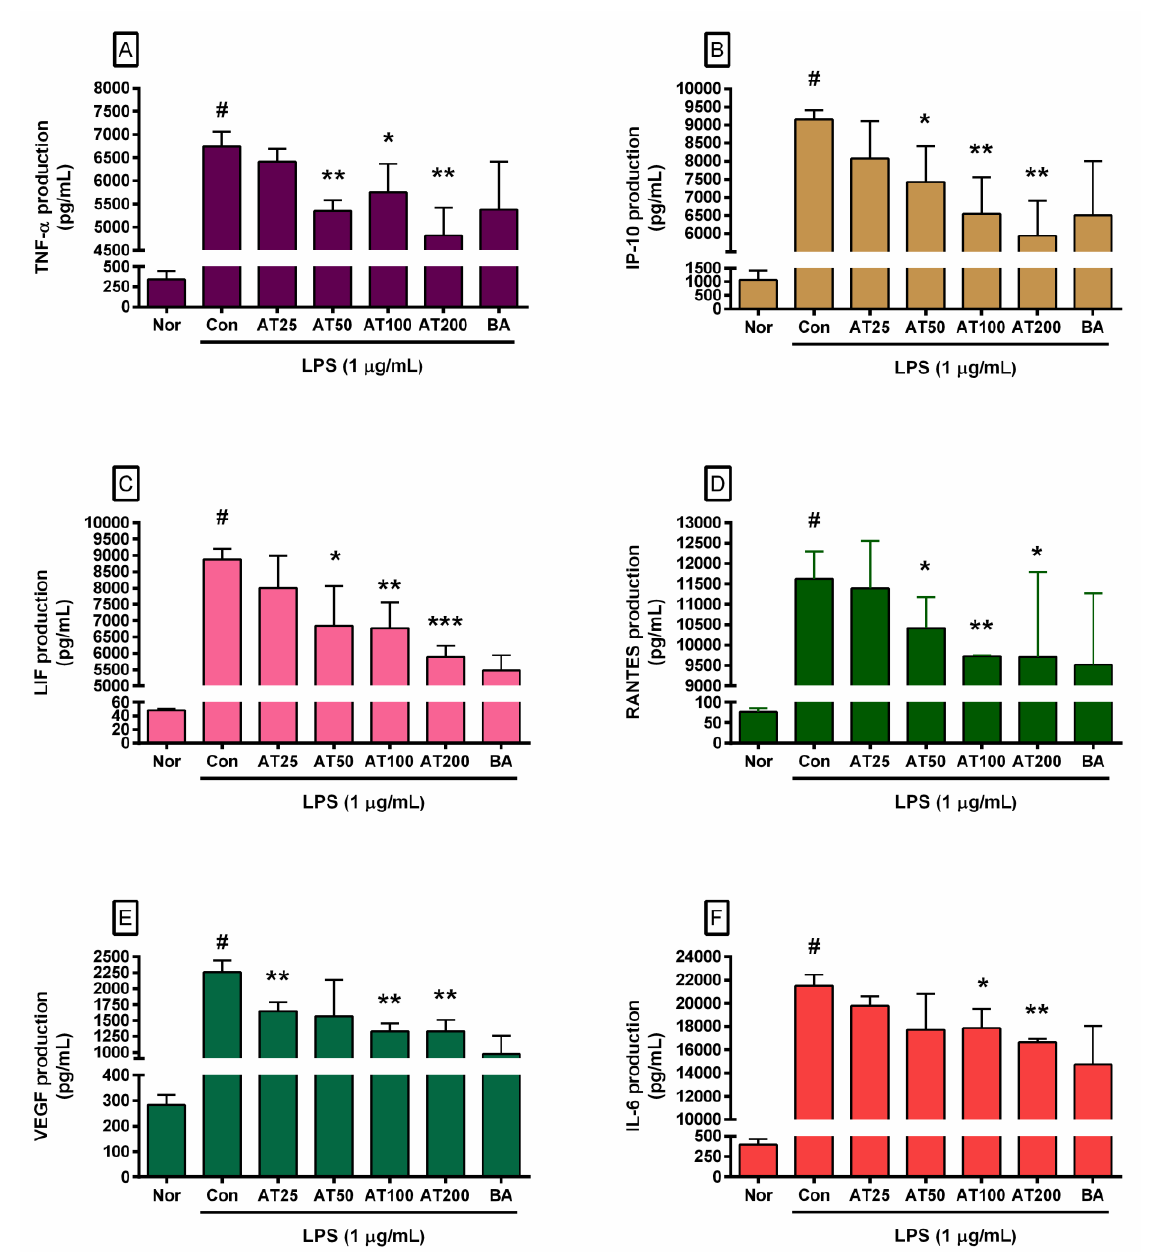
Figure 4. Production of TNF- α ( A ), IP-10 ( B ), LIF ( C ), RANTES ( D ), VEGF ( E ), and IL-6 ( F ) in RAW 264.7 activated by LPS. Values are presented as mean ± SD. Nor, the group treated with cell culture media alone; Con, the group treated with lipopolysaccharide (LPS, 1 µ g/mL) alone. AT25 means 25 µ g/mL of AT, AT50 means 50 µ g/mL of AT, AT100 means 100 µ g/mL of AT, and AT200 means 200 µ g/mL of AT. BA, baicalein (25 µ M). #, p < 0.05 vs. Nor; *, p < 0.05 vs. Con; **, p < 0.01 vs. Con; ***, p < 0.001 vs.